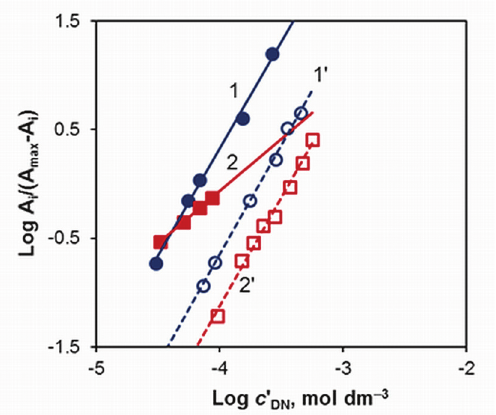
Figure 4: Determination of the DN:vanadium molar ratios by the mobile equilibrium method; m = 1. pH 5.5, c